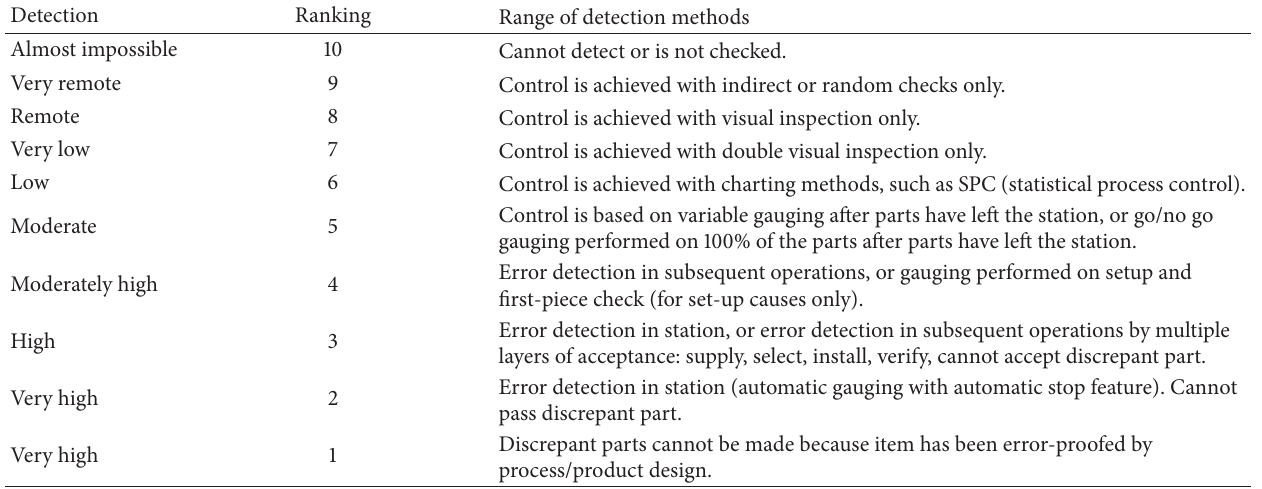
Table 3: Detection evaluation criteria.